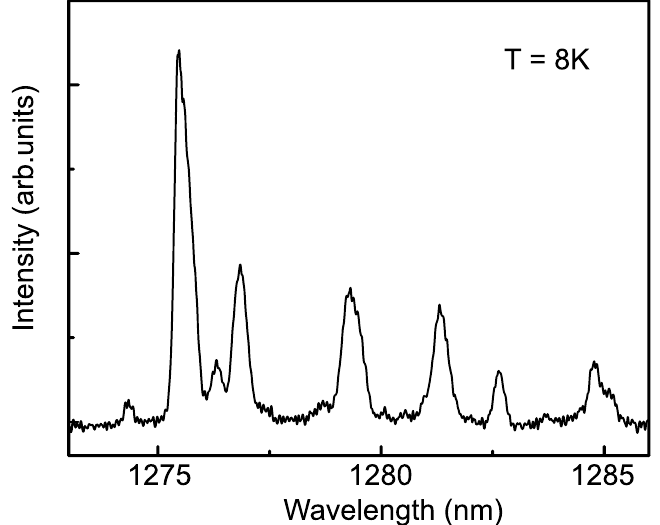
Figure 2. A representative µ -PL spectrum measured in a photonic nanoantenna with InAs QDs at 8 K.